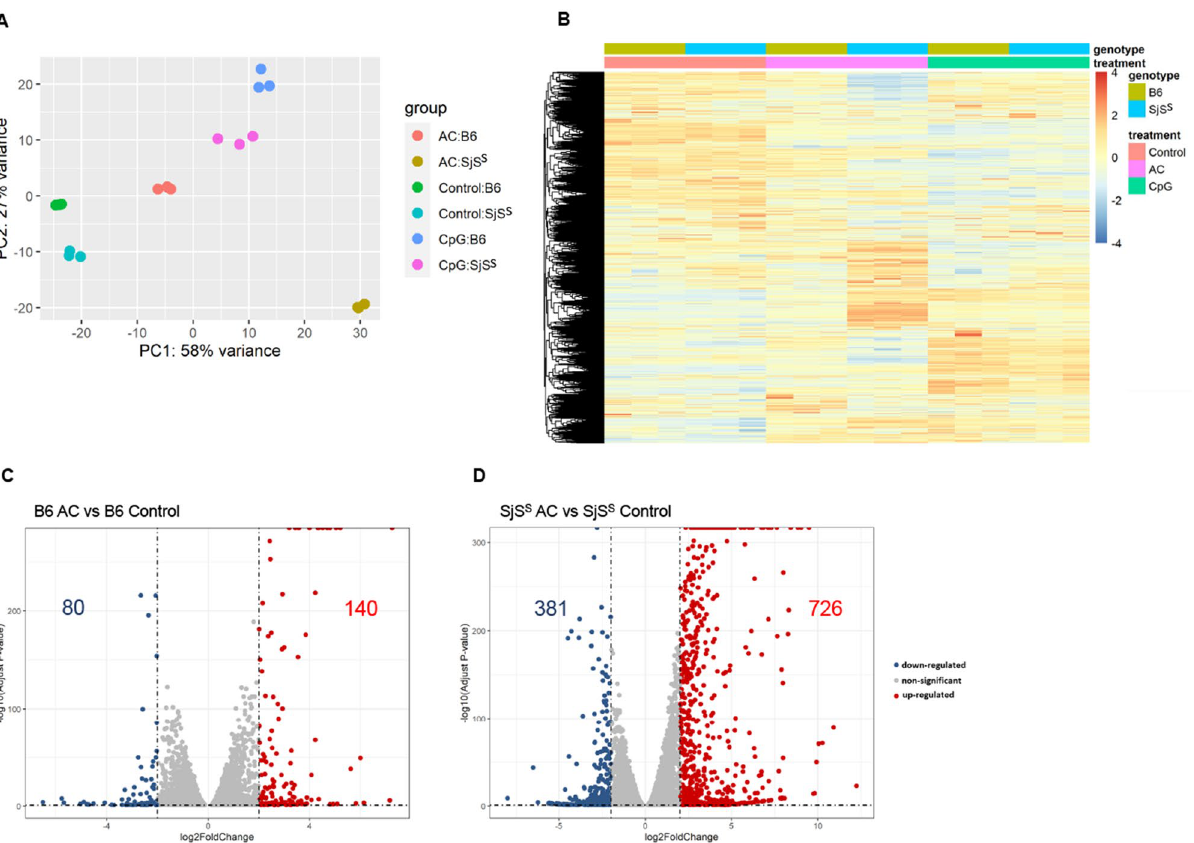
Figure 1. Efferocytosis induces distinct transcriptional profiles in B6 and SjS S BMDMs. BMDMs were cultured from B6 (n = 3 mice) and SjS S mice (n = 3 mice) and untreated or treated with CpG or apoptotic cells (AC). Following incubation, cells were washed three times and incubated an additional 3 h before RNA was collected for RNA-Seq. ( A ) Principal component analysis (PCA) plot of whole transcriptome RNA Seq data Control B6 (green), Control SjS S (teal), CpG B6 (blue), CpG SjS S (purple), AC B6 (red), and AC SjS S (gold) (n = 3). ( B ) Heatmap of differentially expressed genes between Control B6, Control SjS S , CpG B6, CpG SjS S , AC B6, and AC SjS S conditions. ( C,D ) Volcano plot of differential gene expression between Control and AC treatments for B6 ( C ) and SjS S ( D ). Upregulated genes with fold change ≥ 1.3 and P < 0.05 are in red, and down-regulated genes with fold change ≤ 1.3 and P < 0.05 are in blue. Several significantly altered genes are